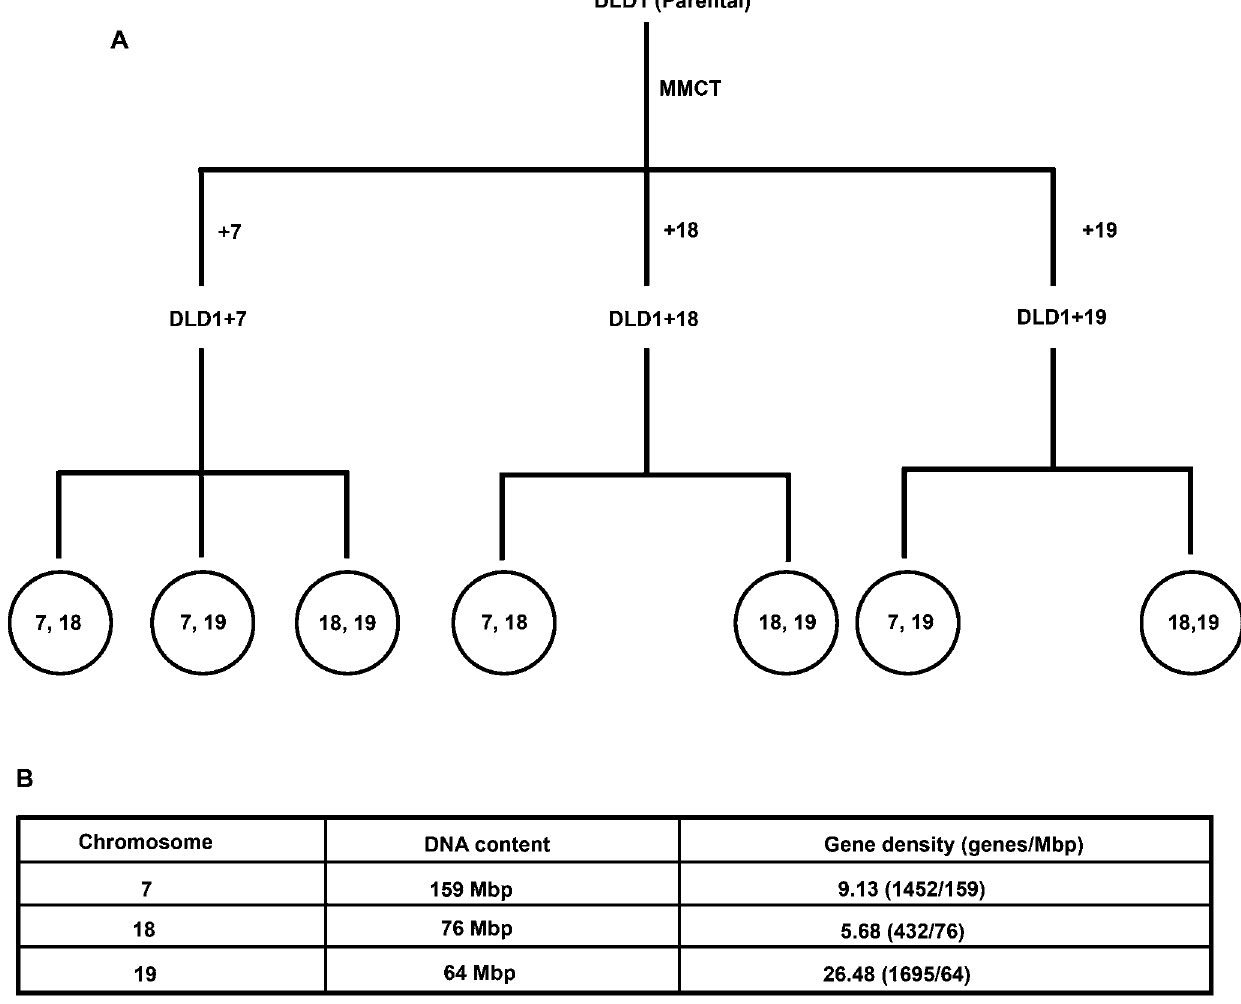
Figure 1. A: Schematic representation of the experimental design. DLD-1 (parental cell line) was subjected to MMCT to generated derivative cell lines DLD-1 + 7, DLD-1 + 18 and DLD-1 + 19. 3D-FISH was performed on each of the derivative cell lines with the probe combinations indicated. B: Table showing comparisons of DNA content and gene density between Chromosome 7, 18 and 19.